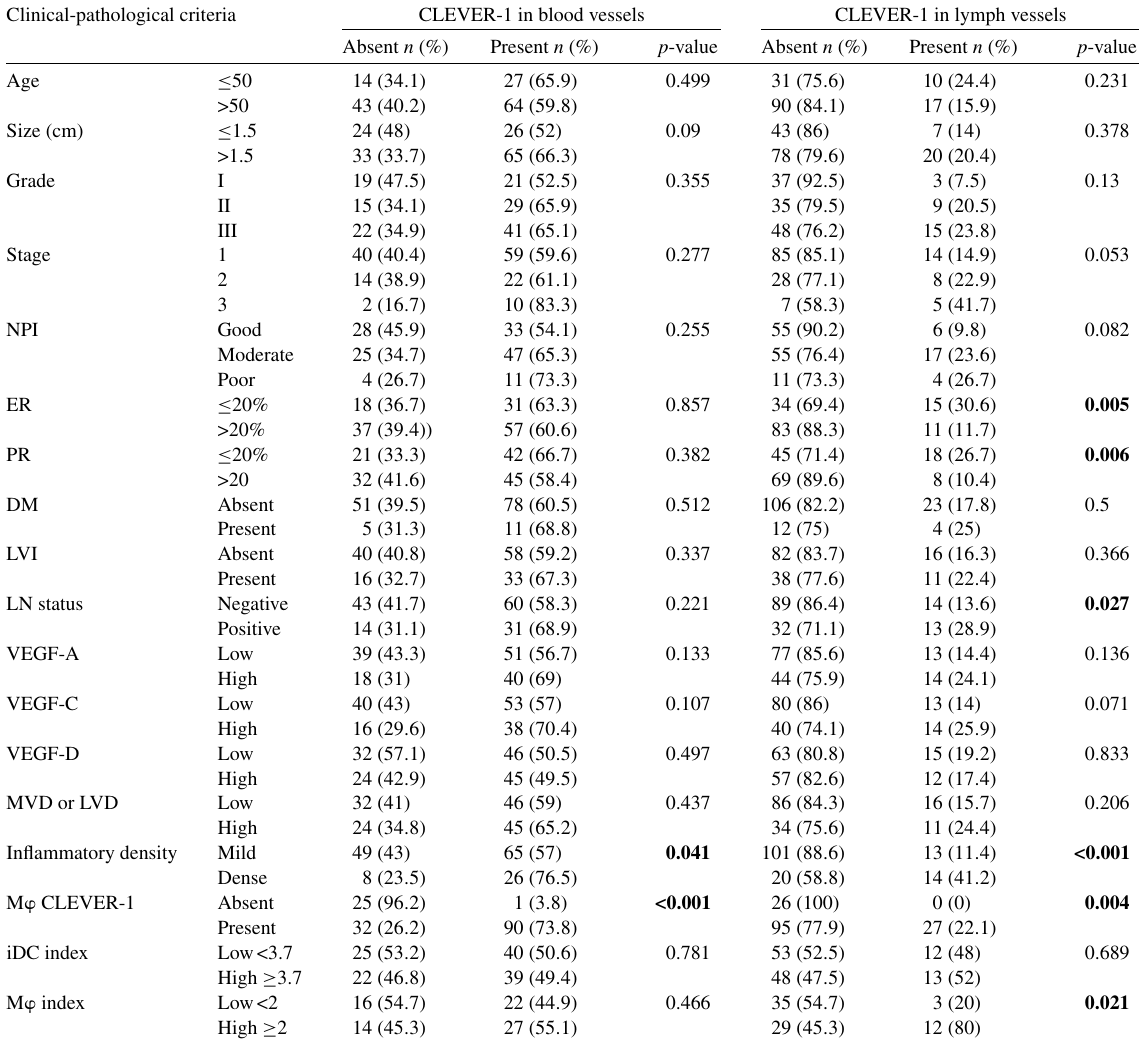
Correlation of CLEVER-1 expression on blood and lymph vessels with clinicopathological criteria and with iDC and M (cid:1) indices Clinical-pathological